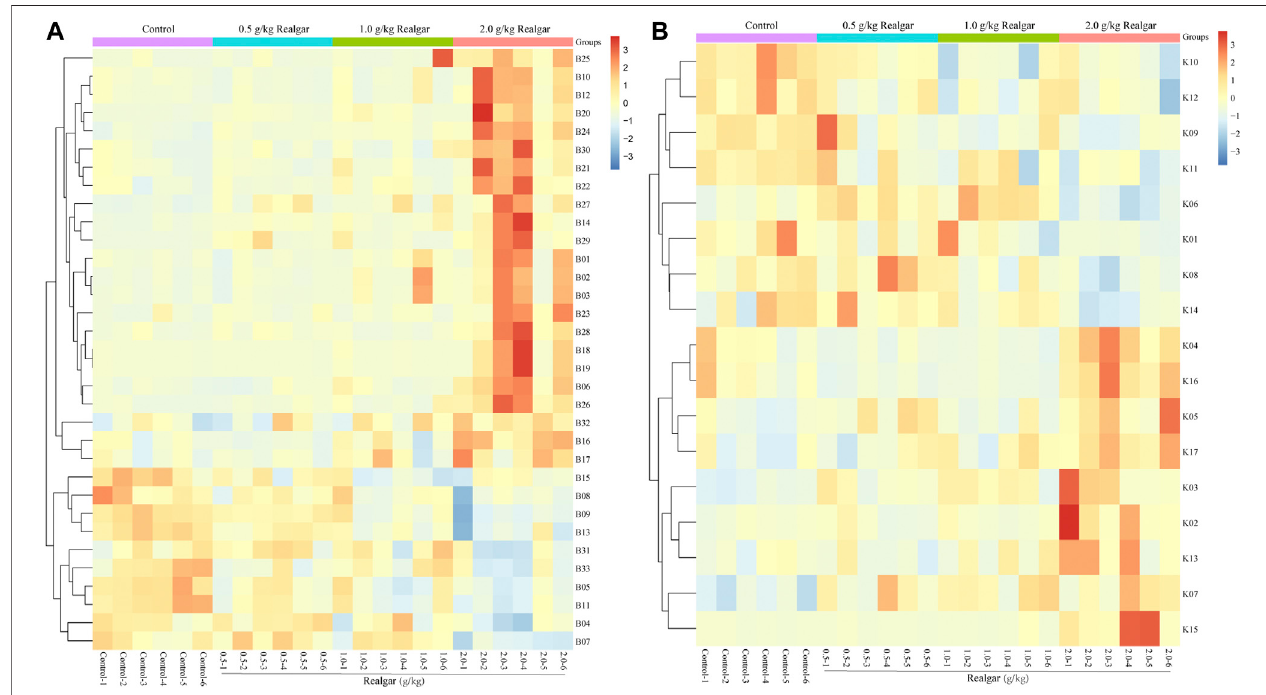
FIGURE 4 | Heatmap of potential biomarkers of (A) serum and (B) kidney ( n (cid:2) 6). Rows represent the relative intensities of metabolites, where red represents high relative abundance metabolites and blue represents low relative abundance metabolites. Columns represent individual serum or kidney samples.